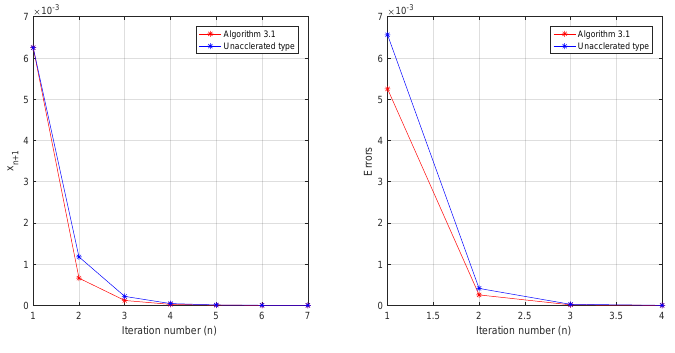
Figure 4: x 1 = 0.007 , Left: accuracy against number of iterations; Right: errors against numbers of